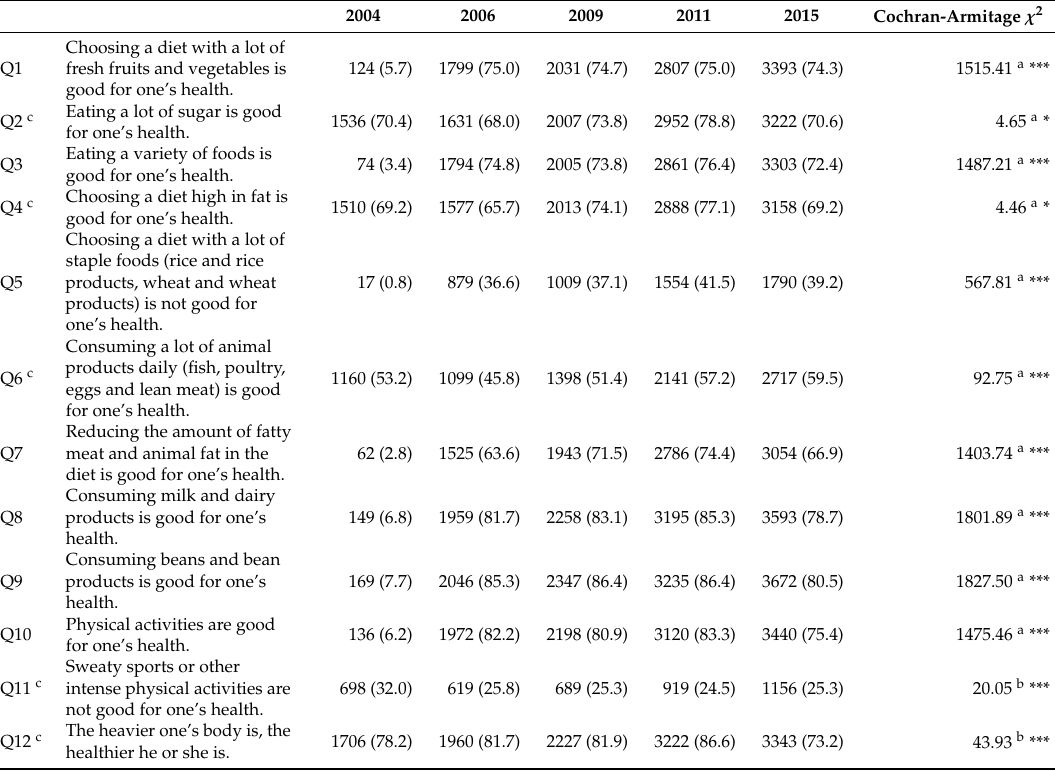
Table 2. The proportion of correctly answering on 12 dietary knowledge in